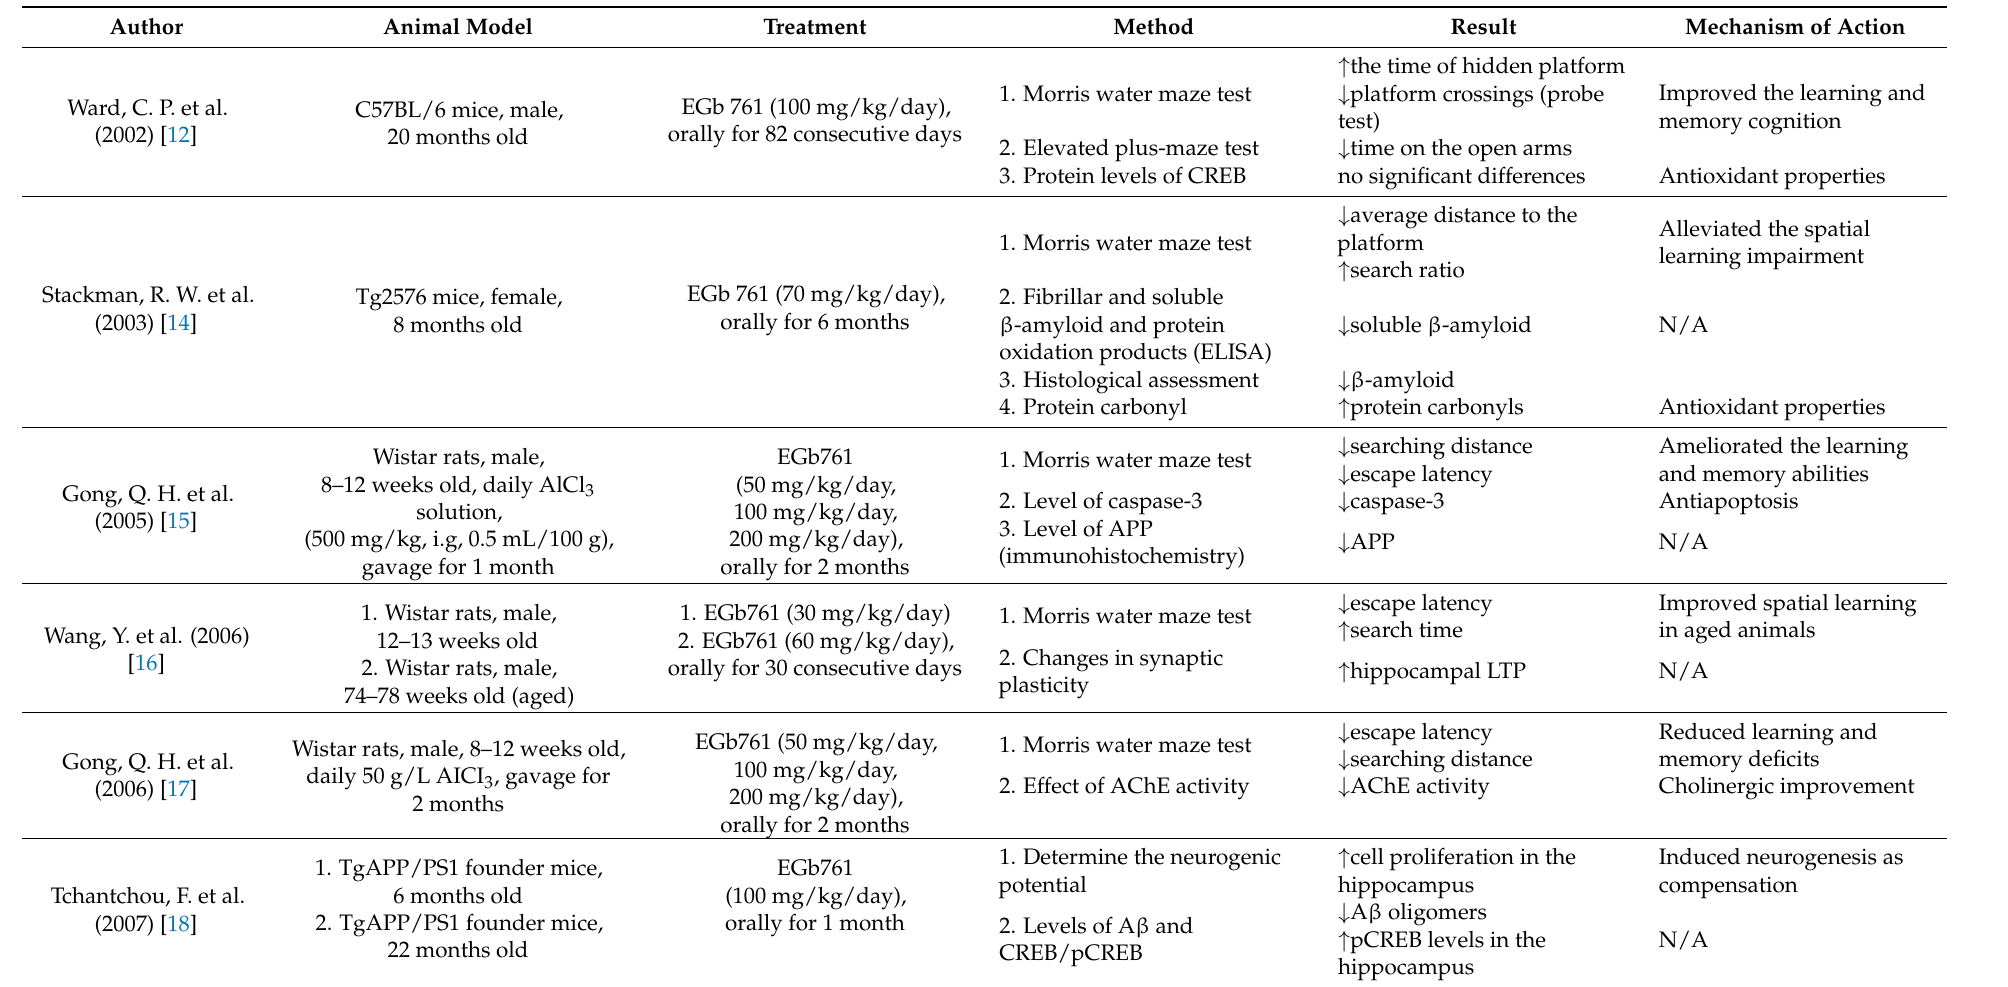
Table 3. Characteristics of included animal studies related to